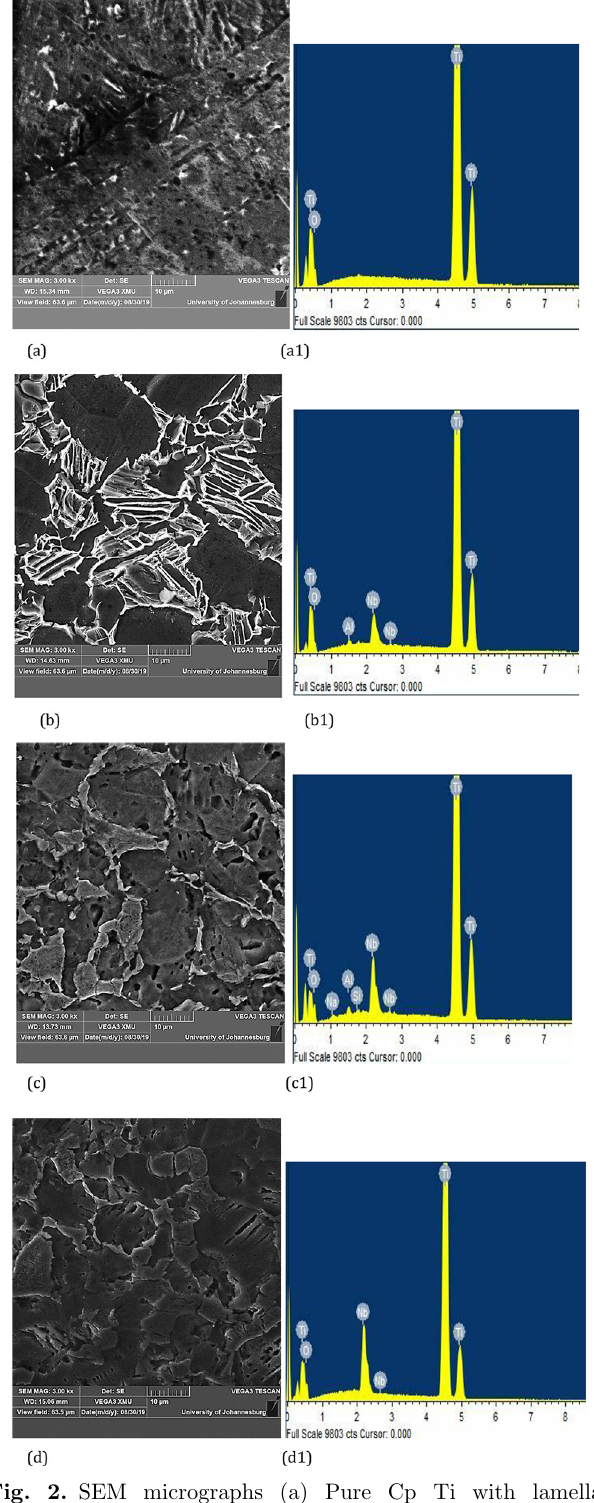
Fig. 2. SEM micrographs (a) Pure Cp Ti with lamellar structure (a1) EDS showing the chemical composition of Cp Ti. (b) Ti (cid:1) 5 wt.% Nb 2 O 5 (b1) EDS showing the chemical composition of the Ti (cid:1) 5 wt.% Nb 2 O 5 (c) Ti (cid:1) 10 wt.% Nb 2 O 5 (c1) EDS showing the chemical composition of the Ti (cid:1) 10 wt.% Nb 2 O 5 (d) Ti (cid:1) 15 wt.% Nb 2 O 5 (d1) EDS showing the